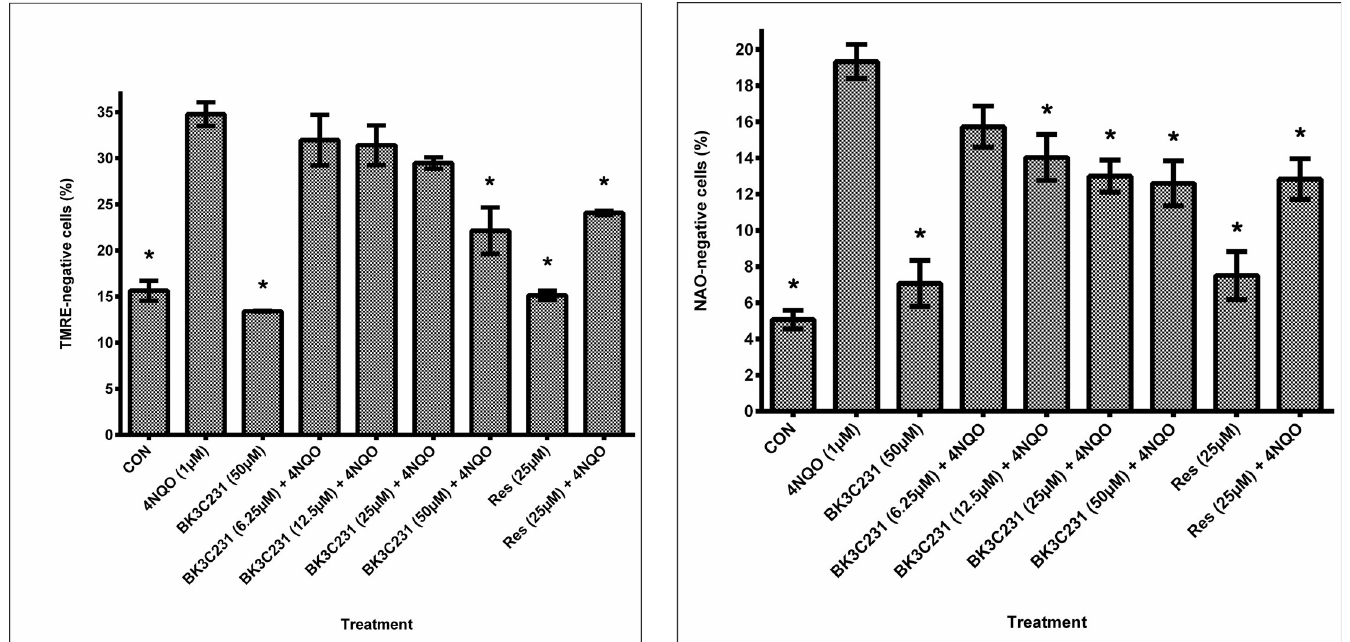
Fig 5. Assessment of mitochondrial toxicity in CCD-18Co cells. (A) Flow cytometric analysis of Δ C m level using TMRE staining. (B) Flow cytometric analysis of cardiolipin level using NAO staining. Cells were pretreated with BK3C231 from 6.25 μ M till 50 μ M and resveratrol (res) at 25 μ M for 2h prior to 4NQO induction at 1 μ M for 2h. Each data point was obtained from three independent experimental replicates and expressed as mean ± SEM of TMRE- or NAO-negative cells (%). � p < 0.05 against positive control, 4NQO only.